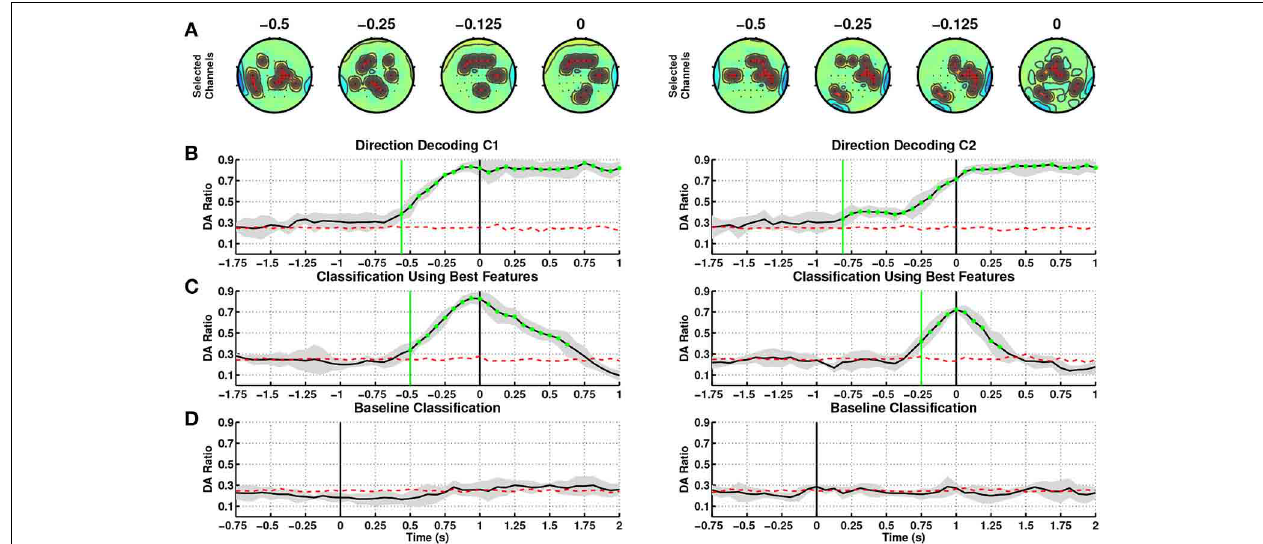
FIGURE 2 | Decoding of movement direction based on the EEG slow cortical potentials (0.1–1Hz). Able-bodied subjects, C1 (left) and C2 (right) performed the reaching with their dominant arm (right for both). (A) Discriminant channels (marked in red) at different time windows of 250ms (ending at 500, 250, 125, and 0ms before movement onset), which form a fronto-parietal network. (B) Direction